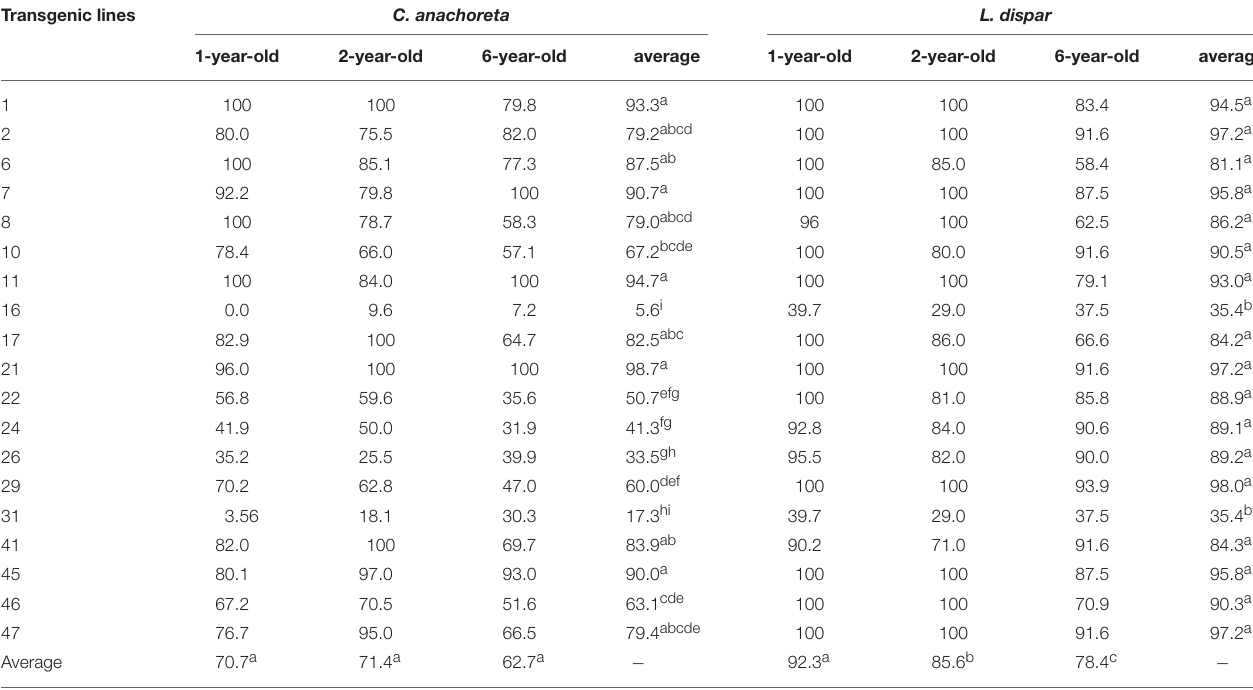
TABLE 1 | Corrected mortality rates (%) of C. anachoreta and L. dispar for 1-, 2-, and 6-year-old plants of 19 transgenic lines. Transgenic